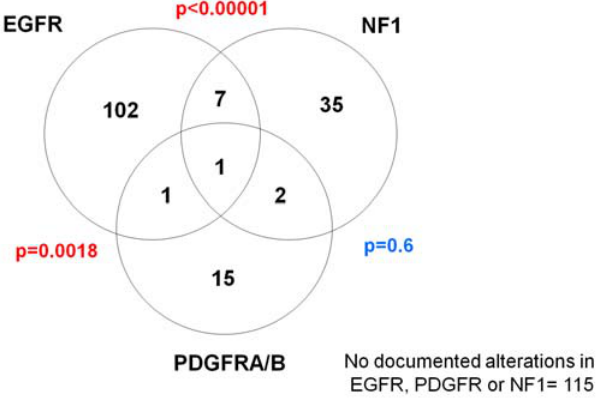
Figure 3. Integration of mutation and chromosomal copy number data from TCGA reveals aberrations of EGFR to be mutually exclusive of aberrations in PDGFRA and NF1. Summary of copy number aberrations (CNA) and mutations of EGFR, PDGFR and NF1 genes in 278 glioblastoma samples from The Cancer Genome Atlas. 163 samples showed mutation/aberration of at least one of the genes. For this summary, only validated, non-synonymous somatic mutations were considered (164/278 samples had sequencing information available). CNA was defined as focal high-amplitude amplification ( . 4 copies) of EGFR or PDGFR, and by at least single-copy loss of